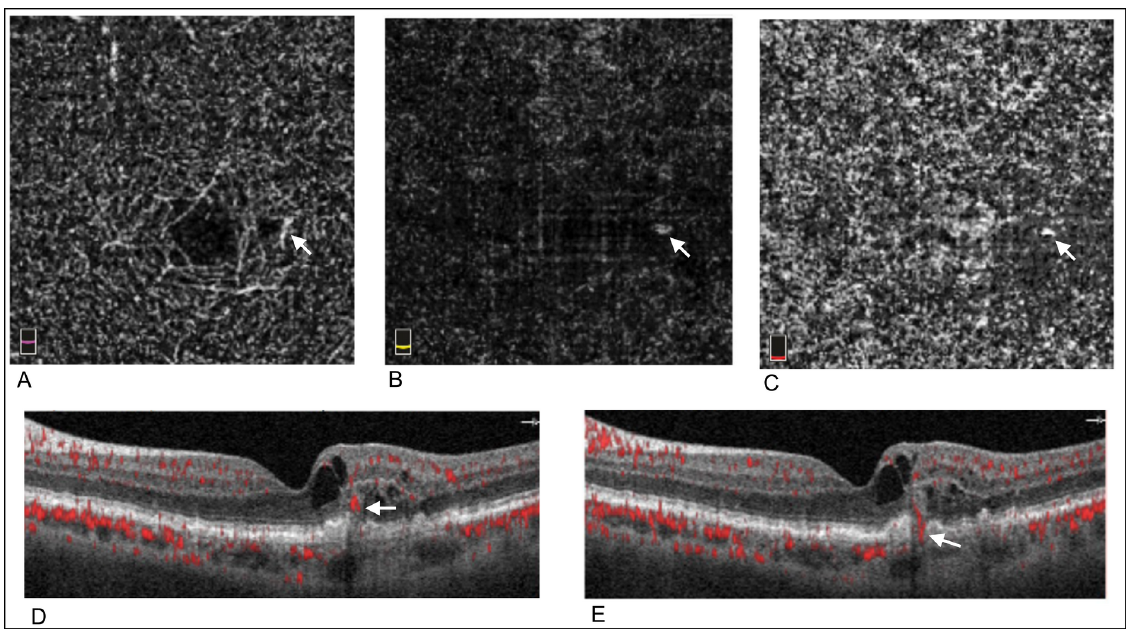
Figure 1. Example of optical coherence tomography angiography (OCTA) signs at baseline in a patient with a type 3 lesion. White arrow shows the lesion on each corresponding scans. ( A ) Dilated vessels can be observed in the retinal deep vascular plexus. ( B , C ) A small vascular tuft is present in the outer retinal slab and choriocapillaris slabs, respectively. ( D ) B-scan showing the presence of flow signal within the outer retina. ( E ) B-scan adjacent to D showing an anastomotic flow passing from the retina through an opened retinal pigment epithelium.